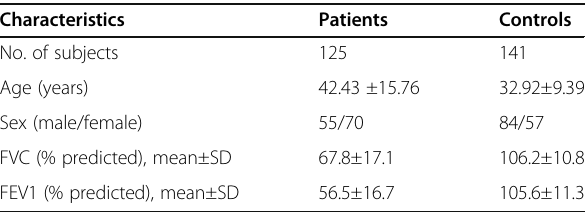
Table 1 Clinical characteristics of the subjects enrolled in the present study (data are mean±SD) Characteristics